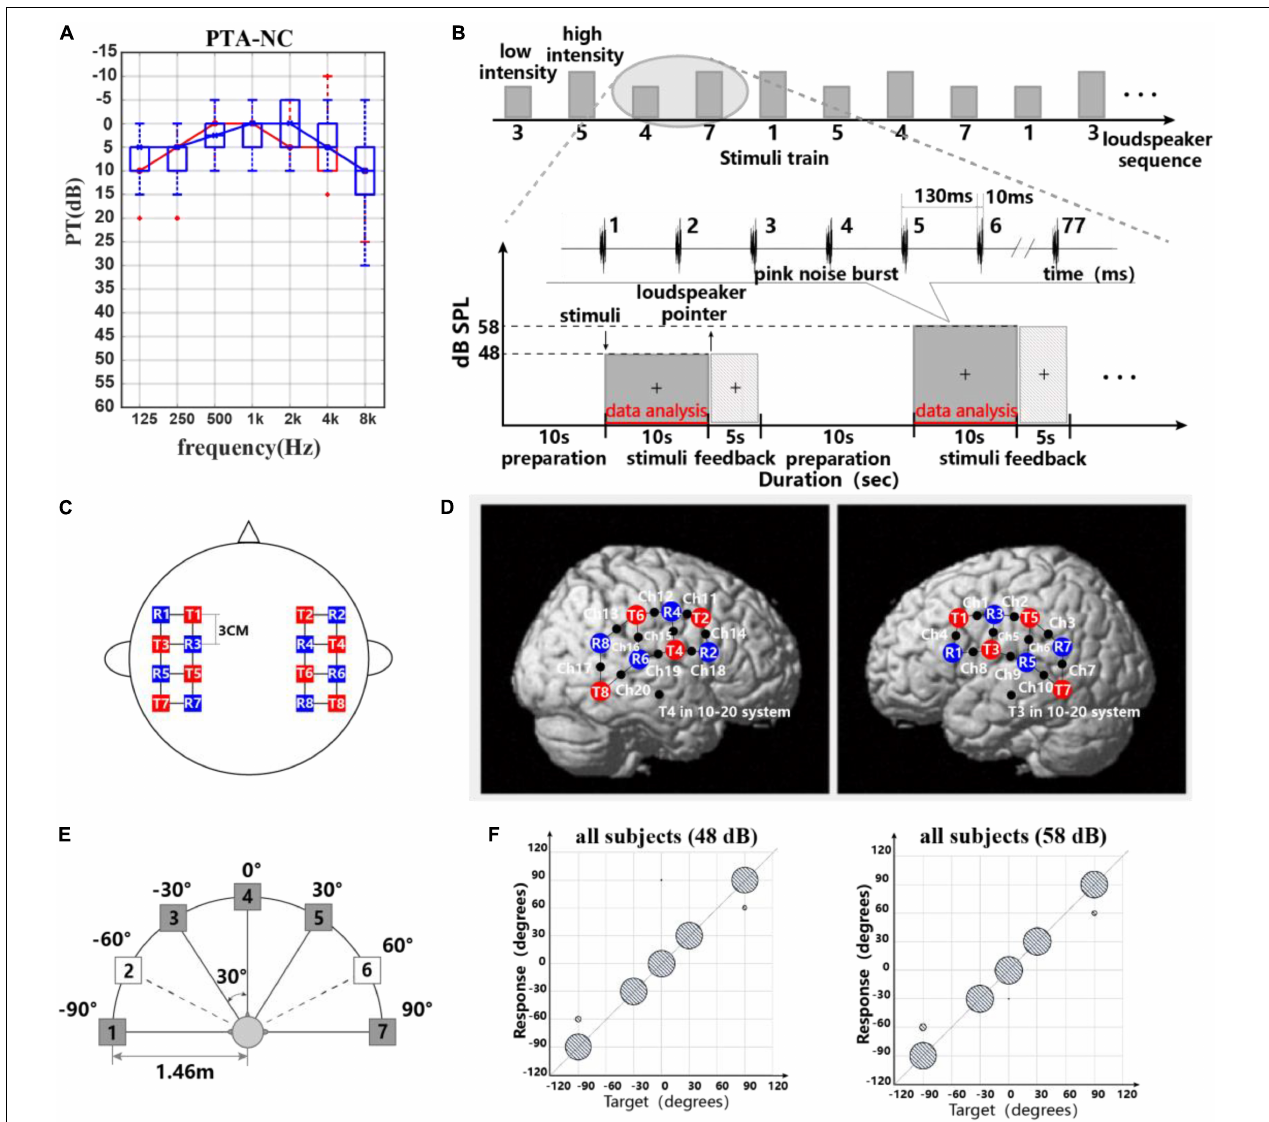
FIGURE 1 | (A) Participants’ pure tone threshold information. (B) Experimental paradigm and stimulus waveform. Block design used for recording task-related hemodynamic responses: five speakers and two different intensity levels were presented in order randomly. Stimulus waveform representations of pink noise bursts. (C,D) Probe layout of the eight sources and eight detectors. (C) Placement of the fNIRS optodes (red squares are sources, blue squares are detectors, and black points on lines are channels). (D) Optode arrangement in both hemispheres. (E) Schematic representation of the seven-loudspeaker system. Loudspeaker 1 and loudspeaker 7 were placed 90 ◦ to the left and right of the straight-ahead (0 ◦ ) position. Loudspeakers 2–6 were placed 30 ◦ apart between loudspeakers 1 and 7. Filled symbols indicate “active” loudspeakers; open symbols indicate “dummy” loudspeakers. (F) Scatter plots for sound source identification with a five-active-loudspeaker array of all subjects in 48 and 58